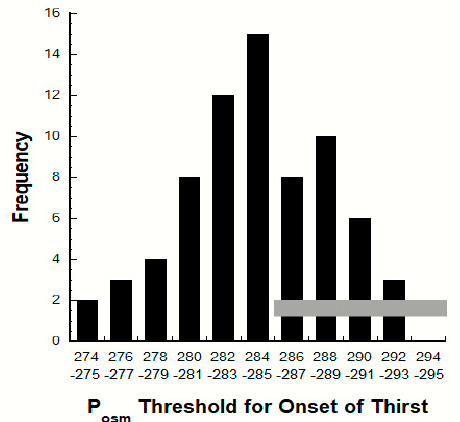
Figure 6. Frequency distribution of the plasma osmolality (P OSM ) threshold for the onset of thirst. The horizontal gray zone represents the laboratory reference range of P OSM values (285–295 mOsm · kg − 1 ) for healthy adults [47].